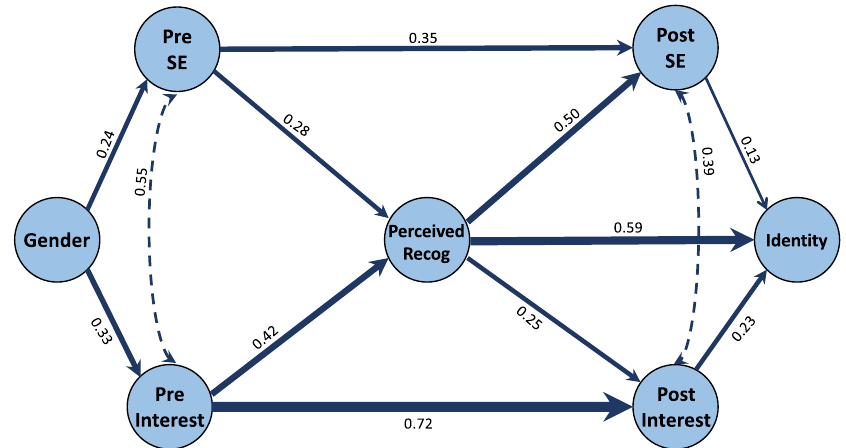
FIG. 2. Schematic diagram of the path analysis part of the structural equation modeling between gender and being a physics person through self-efficacy, interest, and perceived recognition. The solid lines represent regression paths, and the dashed lines represent residual covariances. The regression line thickness corresponds to the magnitude of β value (standardized regression coefficient). All β values are significant with p < 0 . 001